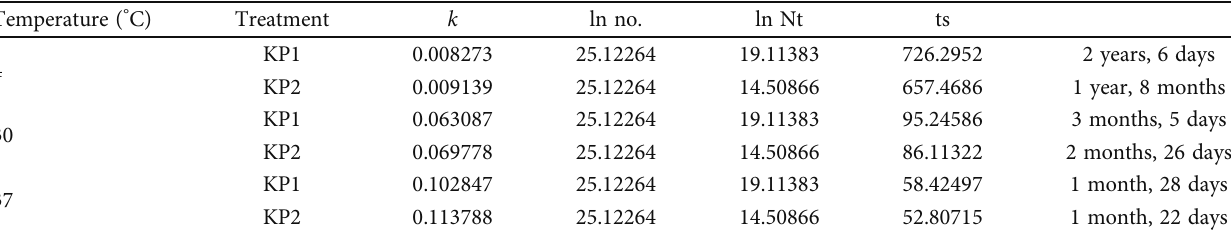
Table 1: Shelf life of probiotic instant co ff